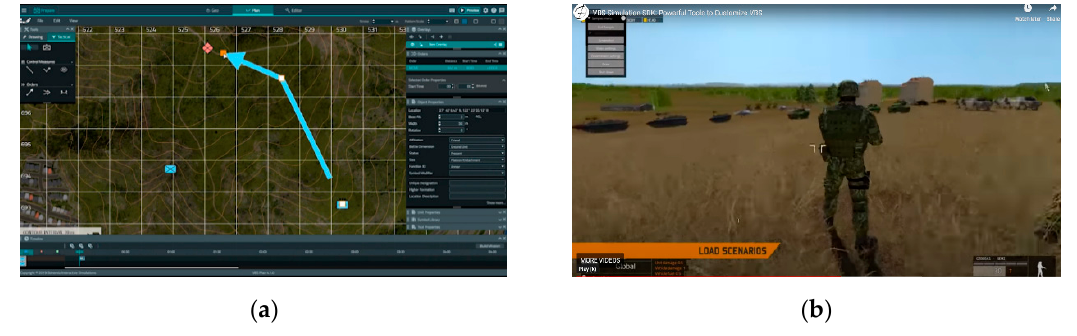
Figure 25. ( a )The LRM screenshots of VBS4, ( b ) The HRM screenshots of VBS4 [64] .